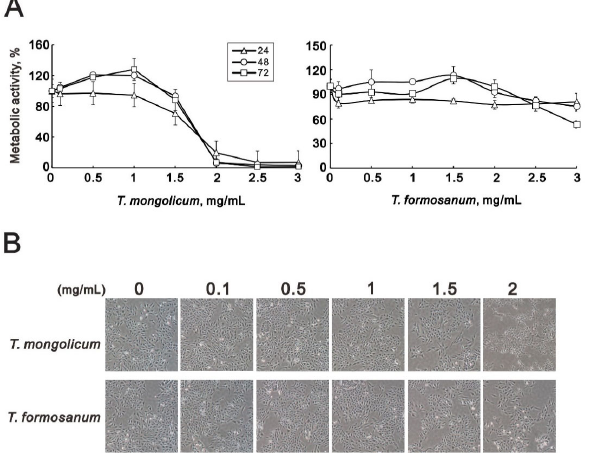
Figure 1. Cytotoxicity of T. mongolicum and T. formosanum in MDA ‐ MB ‐ 231 cells. MDA ‐ MB ‐ 231 cells were treated for 24, 48, or 72 h with the indicated concentrations of T. mongolicum and T. formosanum . ( A ) Metabolic activity was measured using MTT assays and ( B ) cell morphology was observed with light microscopy. The results are representative of three independent experiments. Symbols represent the mean ± SD.